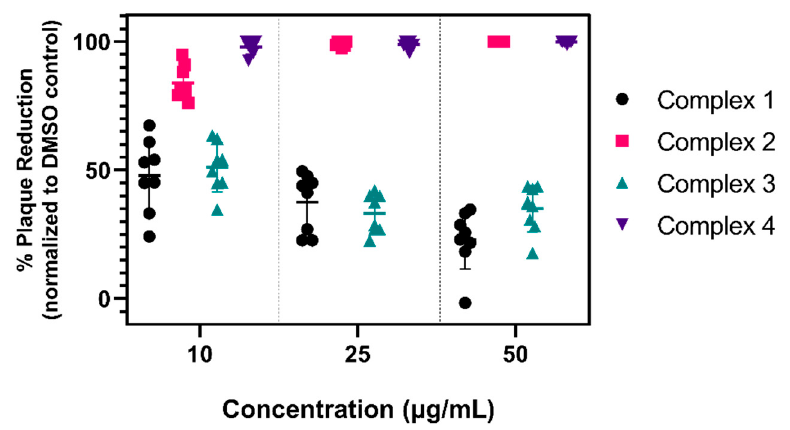
Figure 2. Organometallic complexes exhibit variable antiviral activity against SARS-CoV-2. Each organometallic complex was inoculated with 200 PFU of SARS-CoV-2 at concentrations of 10, 25, and 50 µg/mL and incubated at 37 °C for 3 h. Following incubation, complex–virus mixtures were added to Vero E6 cells for a 1 h adsorption period. Infectious SARS-CoV-2 titers were quantified via plaque assay and data are reported as percent plaque reduction compared to a DMSO–virus control. Data are shown from two biological replicates conducted in quadruplicate per concentration. Horizontal bars represent the mean and error bars represent the standard deviation.